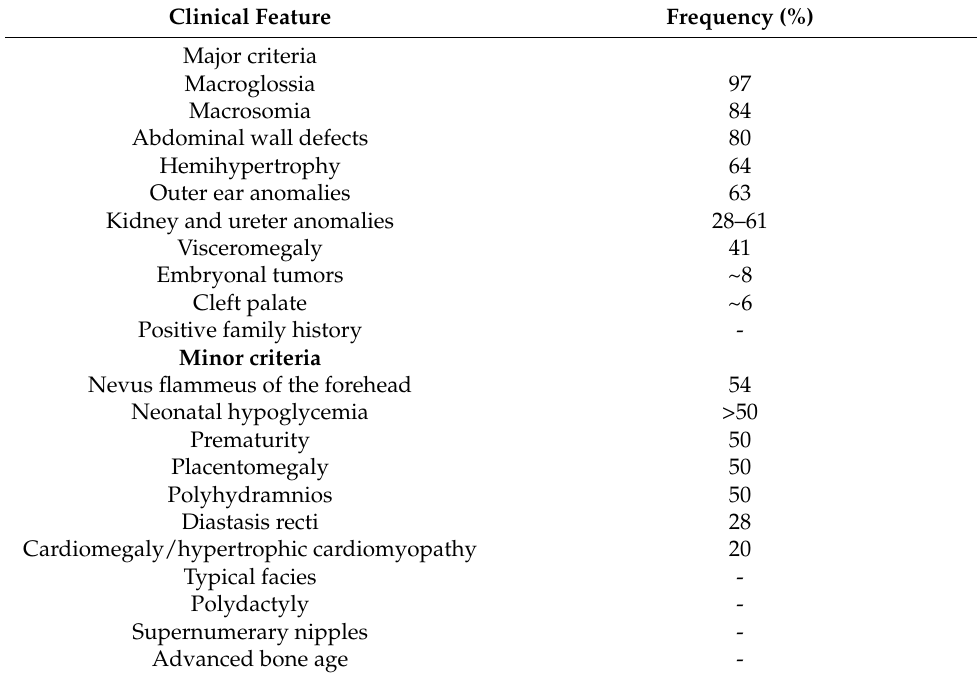
Table 2. Diagnostic criteria for BWS according to Weksberg